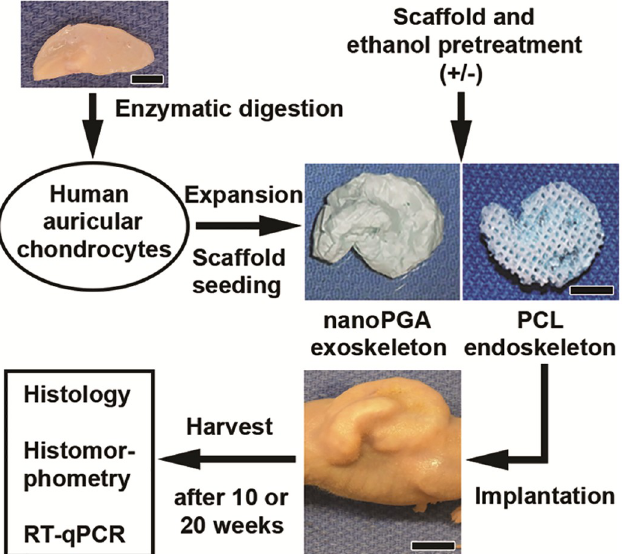
Fig 2. Experimental design for examination of tissue-engineered auricle-shaped constructs of human auricular chondrocytes seeded onto 3D nanoPGA/PCL composite polymeric scaffolds with or without ethanol treatment. The stepwise depiction shows a human surgical biopsy specimen (either normal conchal [otoplasty] or microtia) utilized in the digestion and isolation of auricular chondrocytes. The cells were subsequently expanded in vitro, counted and seeded onto 3D ear-shaped nanoPGA/PCL composite scaffolds consisting of an inner PCL core wrapped in a nanoPGA sheet. Some scaffold composites were treated with graded ethanols before cell seeding and implantation into nude mice for 10 or 20 weeks. On their retrieval, these tissue-engineered constructs were assessed by histology, histomorphometry and RT-qPCR analysis. Scale bars = 1 cm (scaffold, mouse) and 0.5 cm (biopsy tissue). immediately after and throughout the extent of up to 20 weeks of implantation as illustrated in Fig 2. On retrieval from mice after 10 weeks of implantation, auricular constructs whose scaffolds were not treated with ethanol were characterized by thin connective tissue with irregular carti- lage regeneration, identified grossly by its glossy appearance, localized about the auricle tem- plate (Fig 3A). Dissected transversely, such constructs were found with little developed cartilage beneath the specimen surface (Fig 3A1). Following Saf-O and Verhoeff staining of dissected sections, these constructs were marked with proteoglycans (Fig 3A2 and 3A3) and elastic fibers (Fig 3A5), respectively, confined principally to peripheral regions of the con- structs. Interior regions of the constructs were generally devoid of Saf-O and Verhoeff staining and PCL was largely dissolved from the constructs during their processing, leaving empty spaces (Fig 3A2). At some interior sites, tissue was present near such spaces and it was typified by the presence of fibrous material, empty chondrocyte lacunae, weak staining for proteogly- cans, and evidence of large-scale infiltration by inflammatory cells (Fig 3A4 and 3A6). Over the same 10-week implantation period, auricular constructs comprised of scaffolds treated with ethanol were heavily covered with glossy cartilage (Fig 3B) that extended well within the auricle template as observed in transverse profiles (Fig 3B1). An additional distinc- tion from their counterpart control constructs (scaffolds that were not ethanol-treated), sec- tions of constructs whose scaffolds were treated with ethanol maintained greater areas of Saf- O and Verhoeff staining (Fig 3B2), which produced qualitatively richer levels of proteoglycans (Fig 3B3 vs Fig 3A3) and elastic fibers (Fig 3B5 vs Fig 3A5). The interior regions of constructs with ethanol-treated scaffolds maintained numerous chondrocytes residing in their lacunae near PCL-devoid areas and many pockets of strong proteoglycan staining, unlike those regions